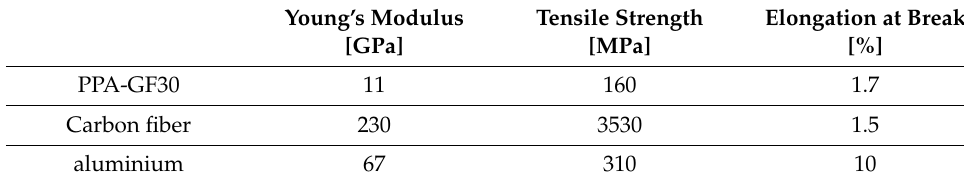
Table 1. Mechanical data of the materials extracted from their data sheets